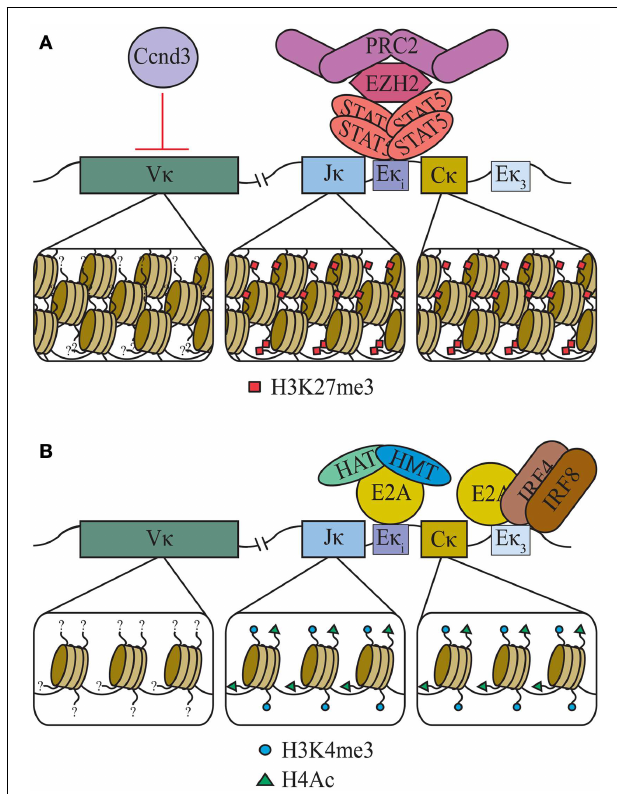
FIGURE 3 | Epigenetic regulation of the Ig κ loci . (A) In large pre-B cells, downstream of the IL-7R, tetrameric STAT5 directly binds at E κ i as a tetrameric complex.This both inhibits E2A binding and recruits the methyltransferase EZH2 and polycomb repressive complex 2 (PRC2) which decorates J κ and C κ with H3K27me3. Additionally, through an unknown mechanism, Cyclin D3 (Ccnd3) restrictsV κ segments’ accessibility. (B) Loss of IL-7R signaling in small pre-B cells leads to a loss of tetrameric STAT5 at E κ i which allows E2A binding and the recruitment of histone methyltransferases (HMT) and histone acetyltransferases (HAT).The resulting H3K4me3 and H4Ac marks open J κ and C κ to transcription and